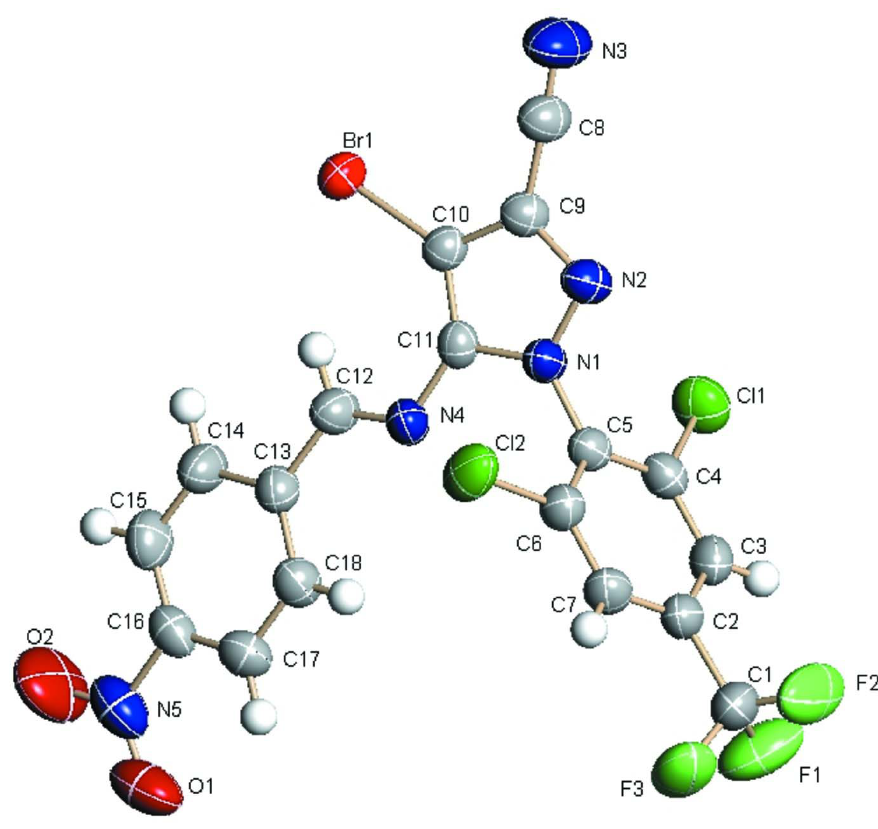
Figure 1 The molecular structure of (I) showing the atom numbering scheme and displacement ellipsoids at 50% probability level. 4-Bromo-1-[2,6-dichloro-4-(trifluoromethyl)phenyl]- 5-(4-nitrobenzylideneamino)-1 H